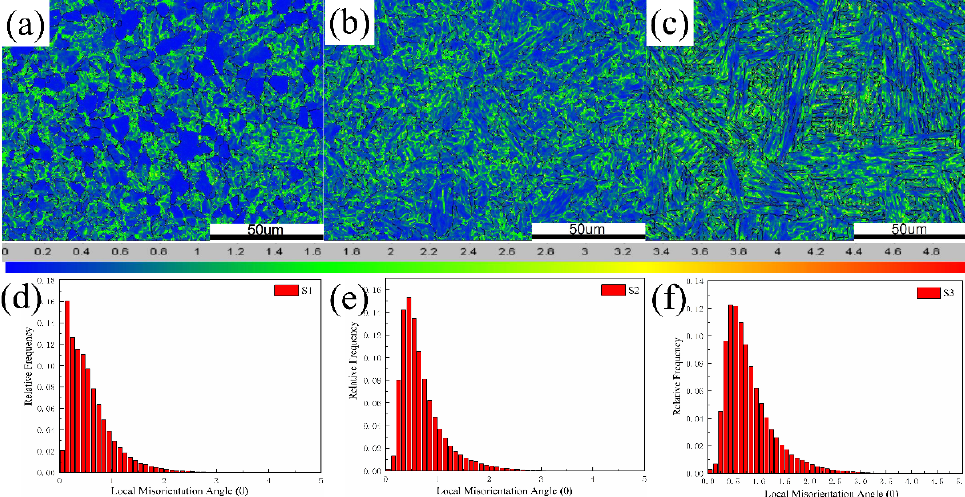
Figure 11. Local misorientation distribution map and the local misorientation frequency distribution: ( a , d ) S1, ( b , e ) S2, and ( c , f ) S3.